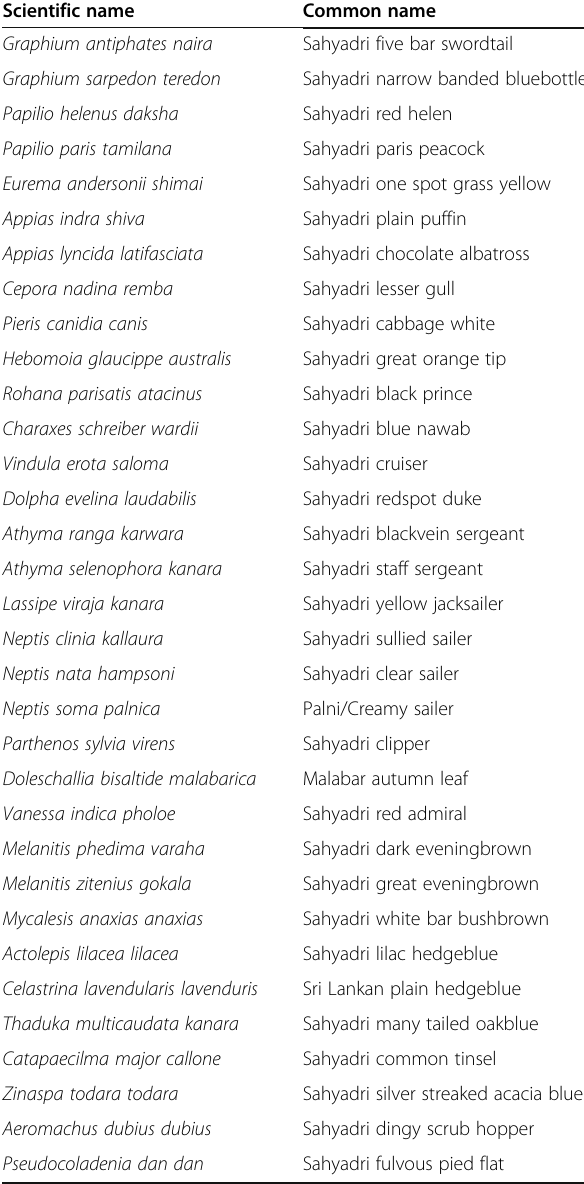
Table 3 Subspecies recorded as endemic to the Western